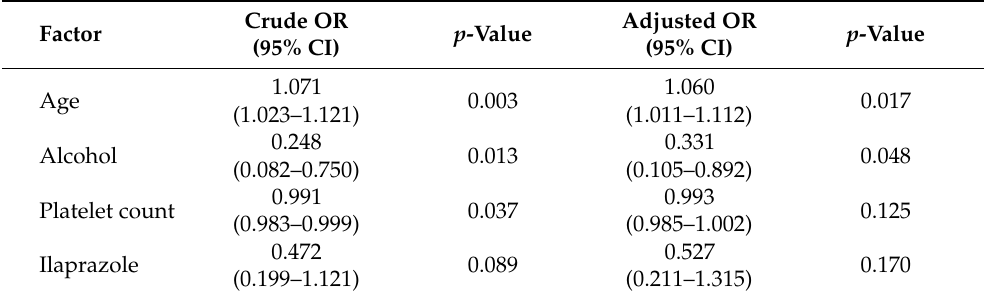
Table 2. Factors associated with clopidogrel resistance.